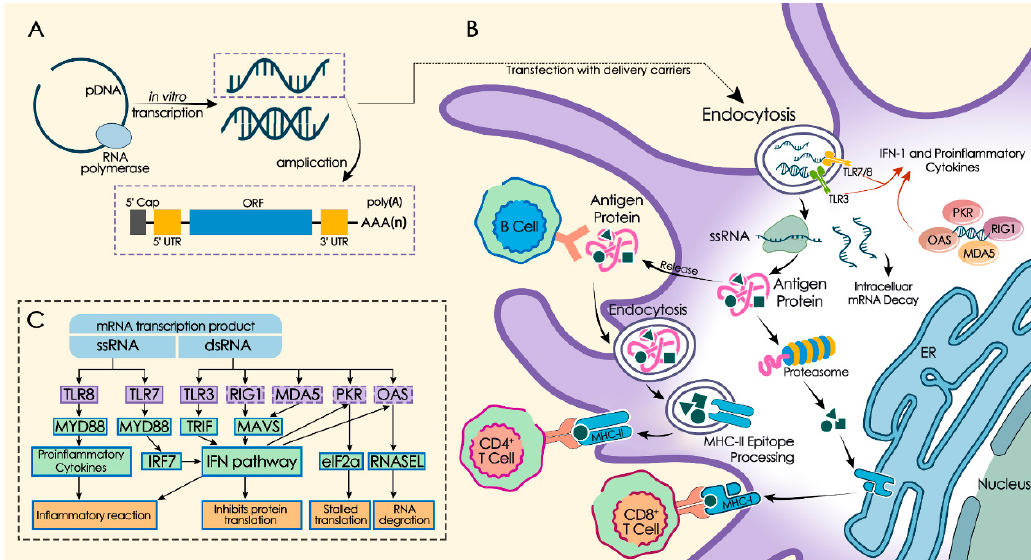
Figure 2. mRNA in vitro transcription and innate immunity activation. ( A ) mRNA in vitro transcription. Using DNA with the antigen-encoding sequence as template, mRNA in vitro transcription products contain single-stranded RNA (ssRNA), double-stranded RNA (dsRNA), etc. The ssRNA structure normally includes five-prime cap (5 ′ cap), five-prime untranslated region (5 ′ UTR), open reading frame (ORF) region, three-prime untranslated region (3 ′ UTR), and poly (A) tail structure. ( B ) RNA translation and antigen presentation. Through endocytosis, mRNAs enter the cytoplasm. Some mRNAs combine with ribosomes of the host cell and translate successfully. Antigen proteins can be degraded to antigenic peptides by proteasome in the cytoplasm and presented to cytotoxic T lymphocytes (CTLs) via major histocompatibility complex (MHC) I pathway. Or, they can be released out of the host cell and taken up by DCs. Then, they are degraded and presented to helper T cells and B cells via MHC-II pathway. B cells can also recognize released antigen proteins. ( C ) Self-adjuvant effect. Various of pattern recognition receptors (PRRs) can recognize mRNA in vitro transcription product. ssRNA can be recognized by endosomal innate immune receptors (e.g., Toll-like receptor 7 (TLR7), TLR8). dsRNA can be recognized by endosomal innate immune receptors (e.g., TLR3) and cytoplasmic innate immune receptors (e.g., protein kinase RNA-activated (PKR), retinoic acid-indu [21]cible gene I protein (RIG-I), melanoma differentiation-associated protein 5 (MDA5), and 2 ′ -5 ′ -oligoadenylate synthase (OAS). Based on those, mRNA products can stimulate the secretion of pro-inflammatory cytokines and type I interferon (IFN), which leads to antigen-presenting cells (APCs) activation and inflammatory reaction. However, they can also activate antiviral enzymes that cause stalled mRNA translation and mRNA degradation.